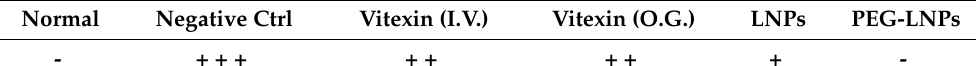
Table 2. Analysis of Ascites of normal versus treatment groups. Normal Negative Ctrl Vitexin (I.V.) Vitexin (O.G.) LNPs PEG-LNPs - + +